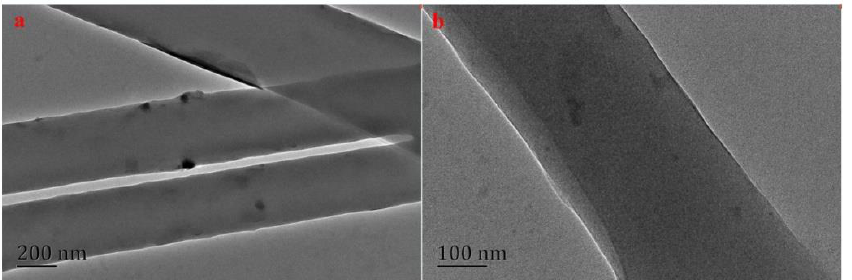
Figure 4. TEM images of 12% nylon6/6% pig nail keratin composite, scale bar: ( a ) 200 nm; ( b ) 100 nm.